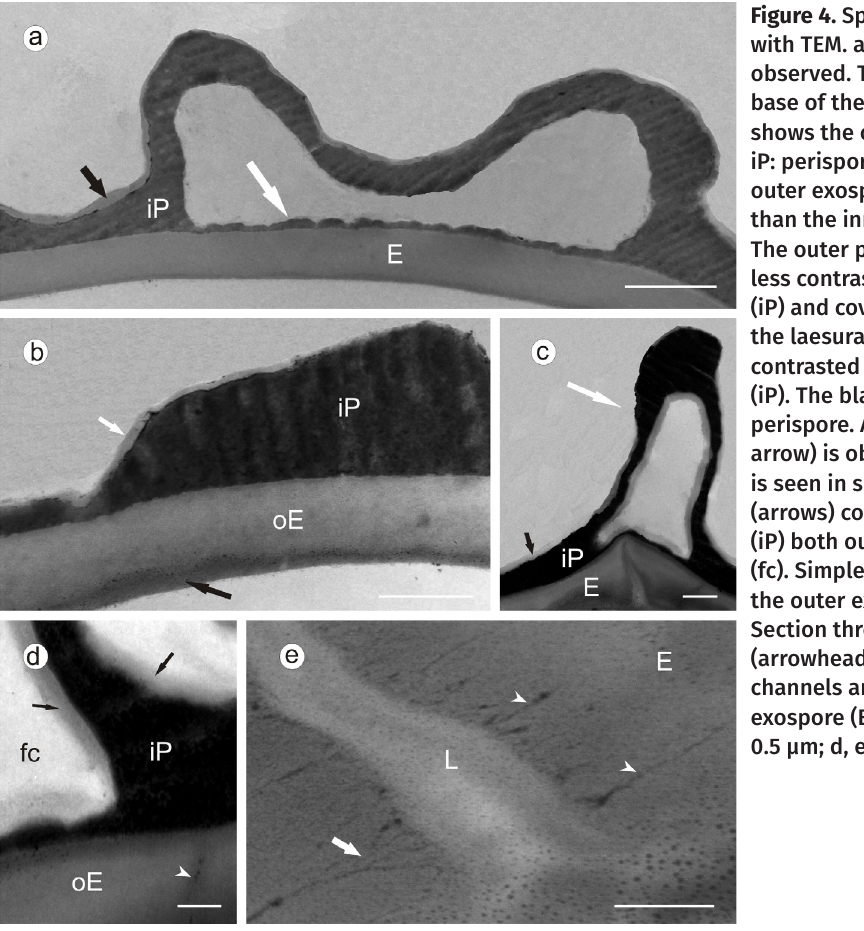
Figure 4. Spores of Dryopteris patula with TEM. a. The folded perispore is observed. The white arrow shows the base of the fold and the black arrow shows the outer perispore. E: exospore. iP: perispore. b. Wall stratification. The outer exospore (oE) is less contrasted than the inner exospore (white arrow). The outer perispore (black arrow) is less contrasted that the inner perispore (iP) and covers it. c. Section through the laesura. The exospore (E) is less contrasted than the inner perispore (iP). The black arrow shows the outer perispore. A supralaesural fold (white arrow) is observed. d. The sporoderm is seen in section. The outer perispore (arrows) covers the inner perispore (iP) both outside the fold as fold cavity (fc). Simple channel (arrowhead) in the outer exospore (oE) is observed. e. Section through the laesura (L). Simple (arrowheads) and branched (arrow) channels are observed in the inner exospore (E). Scale bars: a = 1 µm; b, c = 0.5 µm; d, e = 0.2